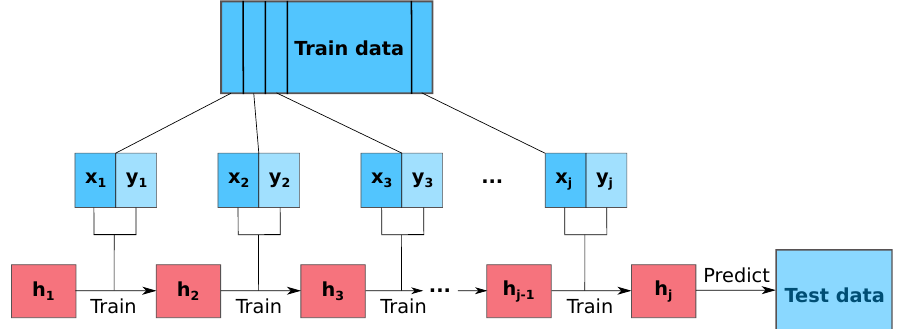
Figure 5. Training and testing of an incremental algorithm in batch processing mode. Note that only the last model is used for